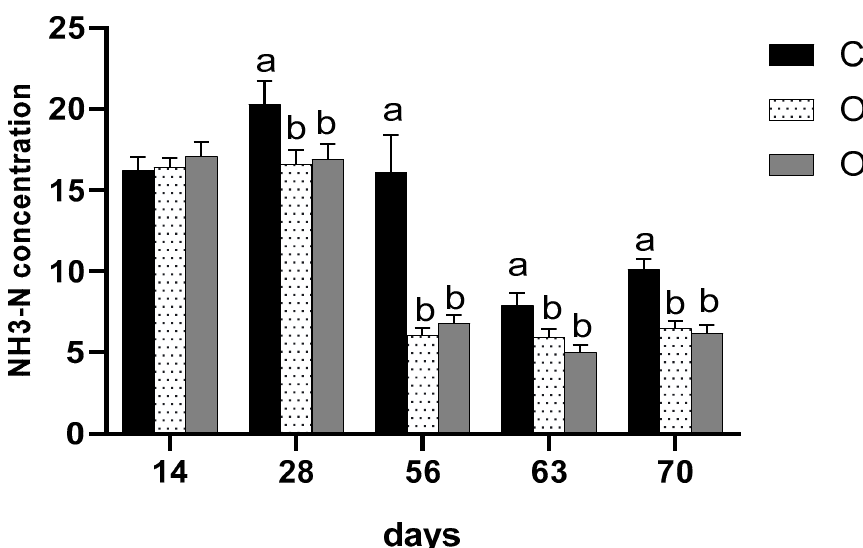
Figure 5. NH 3 -N concentration for Holstein female calves fed basis diet without hay (CON: black bar) and inclusion of short oat hay (OS: 3–5 cm, spots bar) or inclusion of long oat hay (OL: 10–12 cm, gray bar). Different letters within a time point indicate significant differences among treatments ( p < 0.05). Different lowercase letters (a, b) above the bar indicate significant difference ( p < 0.05). Acetate concentration was not different among groups during pre-weaning and entire trial periods (Table 4). A higher proportion of acetate was observed in OS ( p < 0.05) and OL ( p < 0.05) groups during the post-weaning period compared to CON. The CON group had a significantly higher propionate proportion than hay (OL and OS) ( p < 0.05) treatments during post-weaning, while OS group showed a lower propionate proportion than CON and OL during the entire trial. Calves receiving long oat hay had a lower butyrate proportion than the short oat hay ( p < 0.01) during the pre-weaning and post-weaning periods. The CON group had higher TVFA than OL ( p < 0.05) during the pre-weaning and entire trial period. Calves fed with hay had higher value of C2/C3 than CON in post-weaning ( p < 0.05) period. However, no differences were observed between short and long oat hay groups. Table 4. Effect of different lengths of hay supplementation on calf’s rumen volatile fatty acids at different stages 1 . Contrast p -Value Treatment 2 SEM